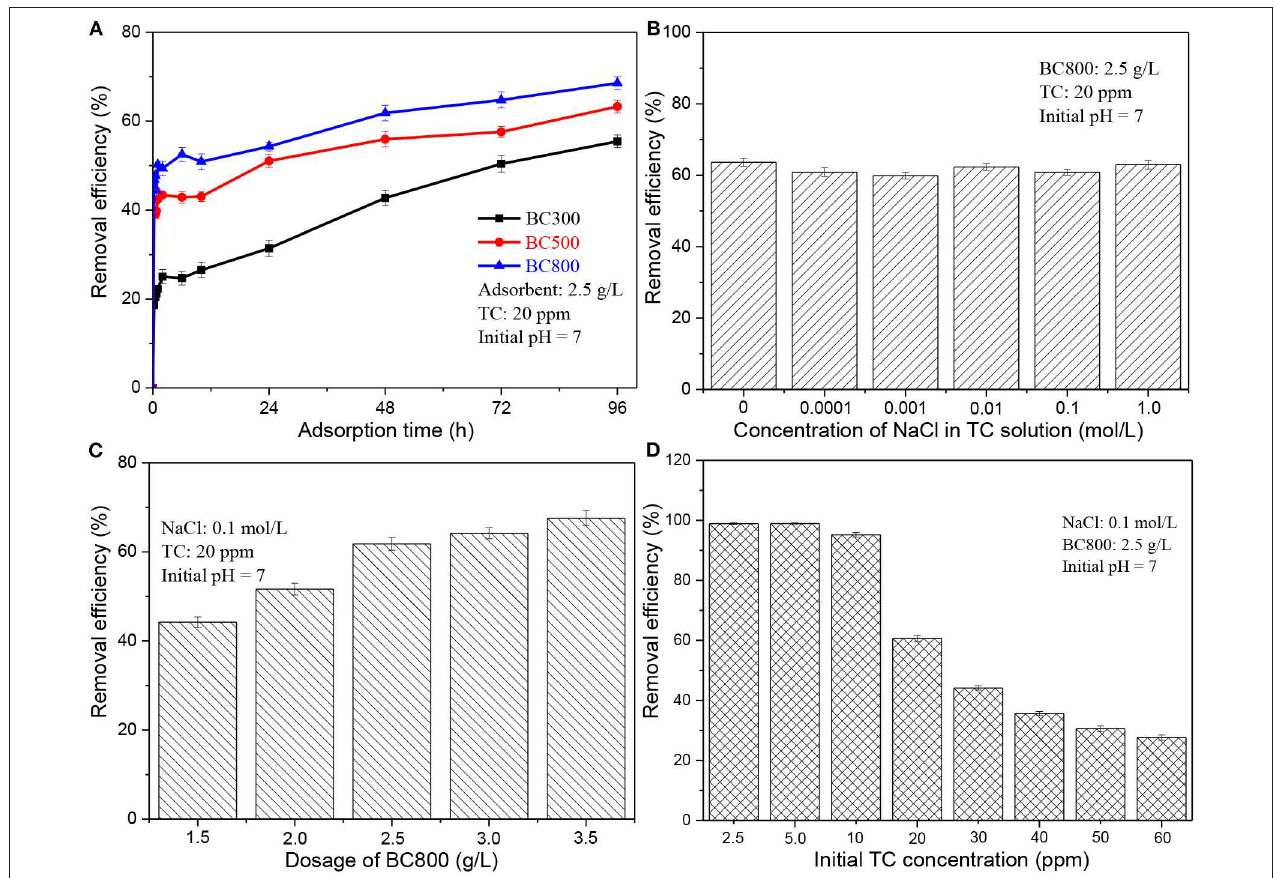
FIGURE 2 | Adsorption performance of (A) BC300, BC500, and BC800 on TC; (B) BC800 on TC with different concentrations of NaCl; (C) BC800 on TC with different biochar dosage; (D) BC800 on TC with different initial concentration. BCXXX stands for biochar prepared at XXX ◦ C; XXX can be 300, 500, and